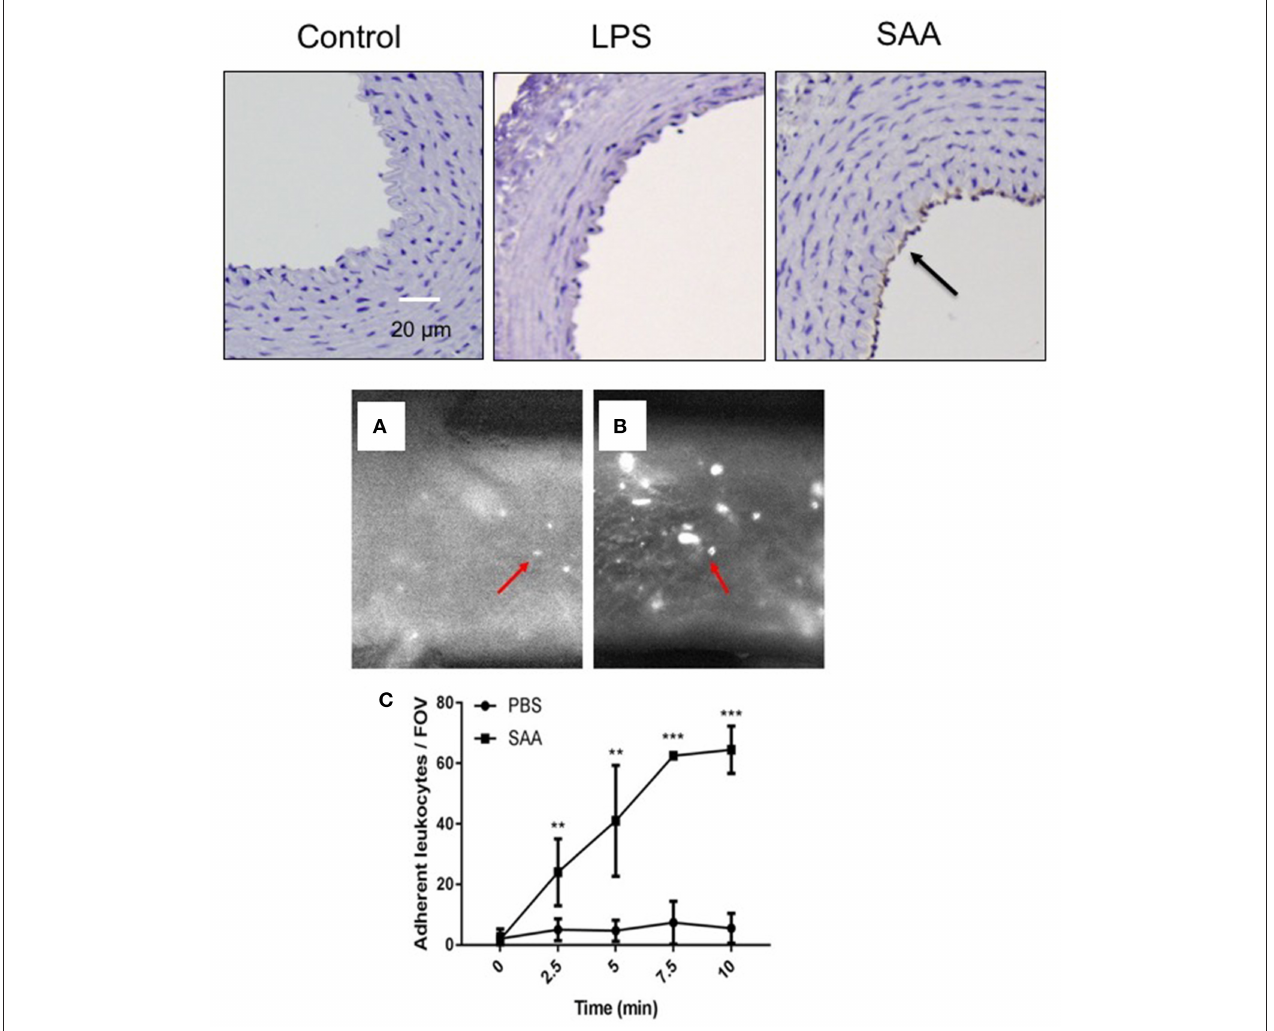
FIGURE 2 | SAA enhances vascular cell adhesion molecule (VCAM) expression in ApoE − / − mice leading to increased adhesion of circulating leukocytes. Upper panels: ApoE − / − mice were injected i.p . with SAA, LPS or sterile PBS vehicle and sacrificed 2 weeks after treatment was finalized (as described under Study 1; experimental design). This sections of thoracic aorta from vehicle (control)-, LPS-, and SAA-treated mice were stained with anti-VCAM-1, counterstained with hematoxylin then imaged by light microscopy (arrow indicates immune-reactive VCAM-1). Data is representative of aortae from n = 6 mice in control and SAA groups and n = 4 mice in the LPS-treatment group. Scale bar = 50 µ m. Lower panels (A,B) : Aortae were isolated from ApoE − / − mice treated with sterile PBS vehicle or SAA (as described under Study 2; experimental design). Aortae were carefully cleaned of fat and placed in an ex vivo dynamic flow adhesion system to assess the adherence of fluorescently labeled leukocytes using a live stage fluorescent microscope as described in Methods. (C) The total number of cells adherent to the vessel wall quantified time-dependently. Data represent mean ± SD , n = 4 mice per group. ** Different to the vehicle control; P < 0.05; *** Different to the vehicle control; P <